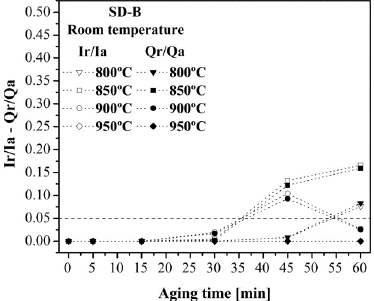
/I and Q /Q versus aging time for SD-B in 2.00 M H r a r a